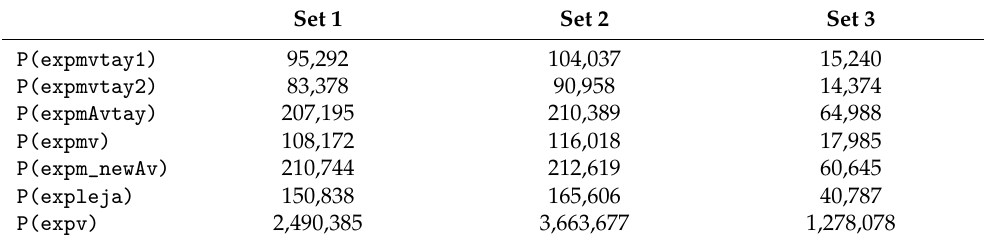
Table 5. Matrix–vector products (P) corresponding to the codes under evaluation for Sets 1–3.